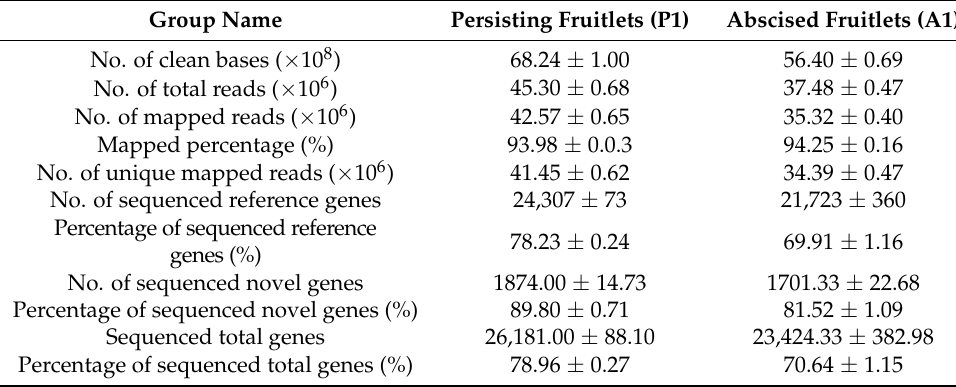
Table 1. Sequencing and statistics of transcriptome data of two groups with reference genome